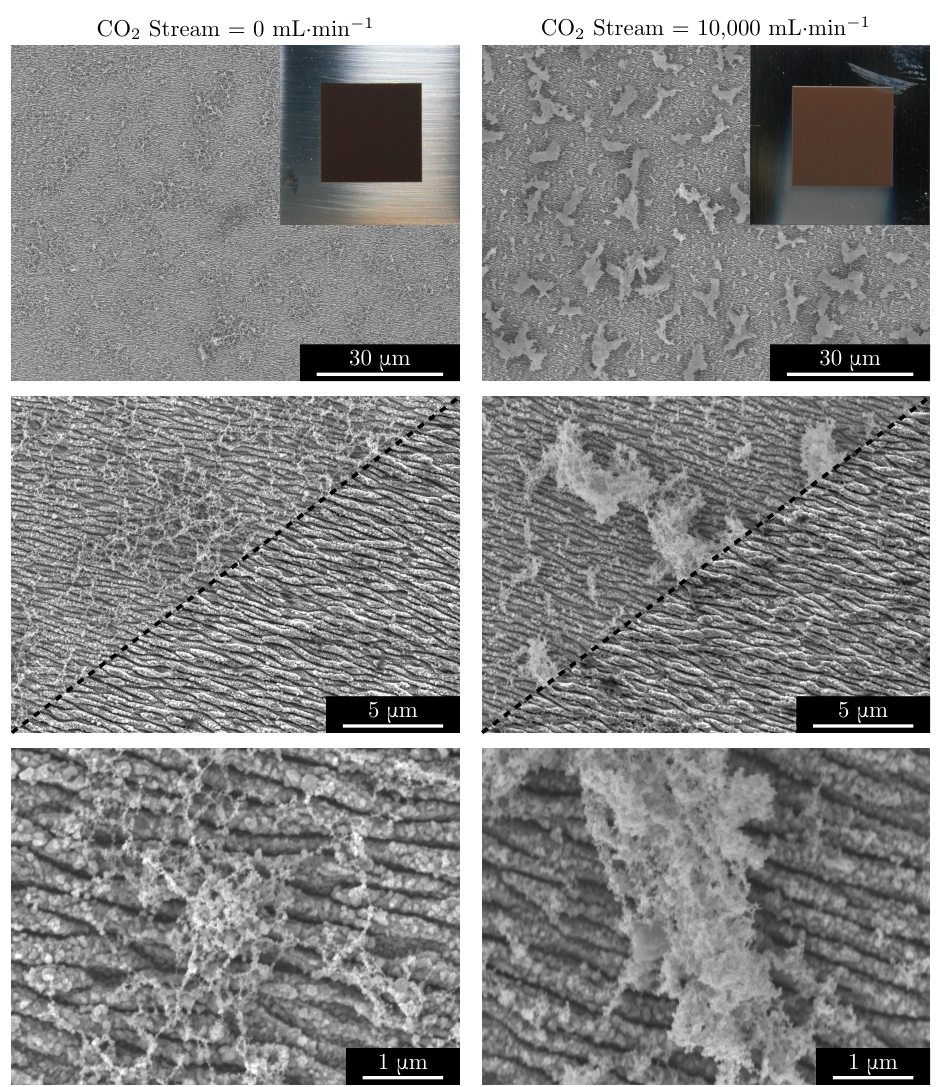
Figure 3. Scanning electron micrographs of the surfaces produced by fs-laser micromachining with (right column) and without (left column) a CO 2 stream. Inset photographs of the top row demonstrate the CO 2 jet serves to confine the area of nanoparticle (agglomerate) redeposition to downstream from the nozzle. Middle row shows a comparison between the surfaces after micromachining (upper left) and after ultrasonication (lower